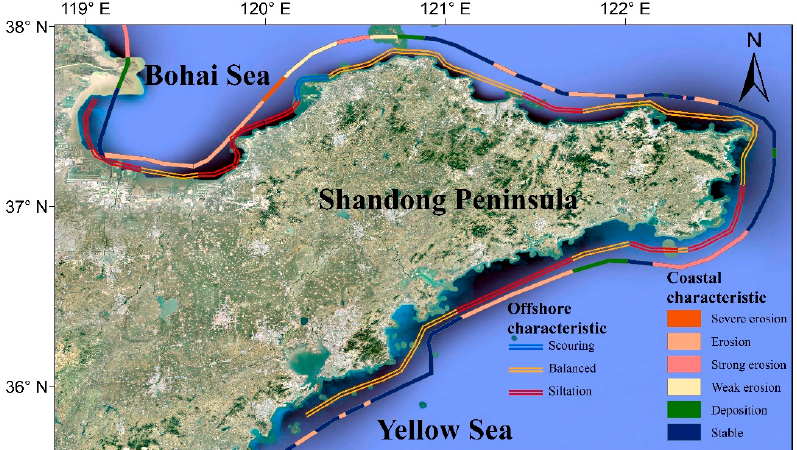
Figure 17. Contrast map of offshore scouring, siltation, and coastal-erosion distribution in the Shan- dong